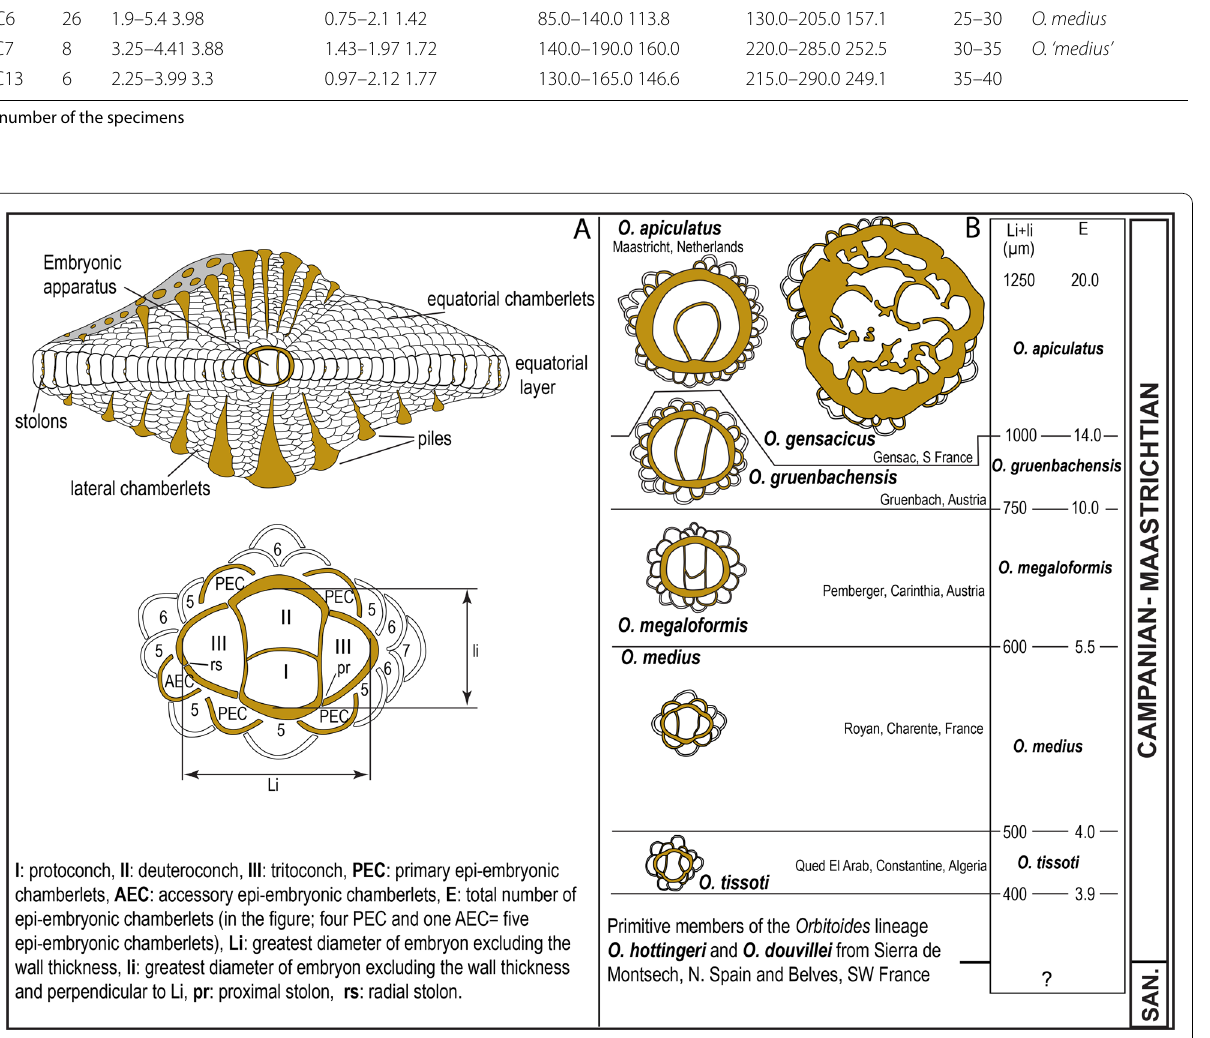
Fig. 6 a Morphological elements of genus Orbitoides ; block diagram of the test and nomenclature for embryonic-nepionic stage of the megalospheric generations. b Schematic morphological changes in Orbitoides and their stratigraphic relationship. Species parameters and limits are shown. Nomenclature is after van Hinte (1965) and Baumfalk (1986), and species limits after van Hinte